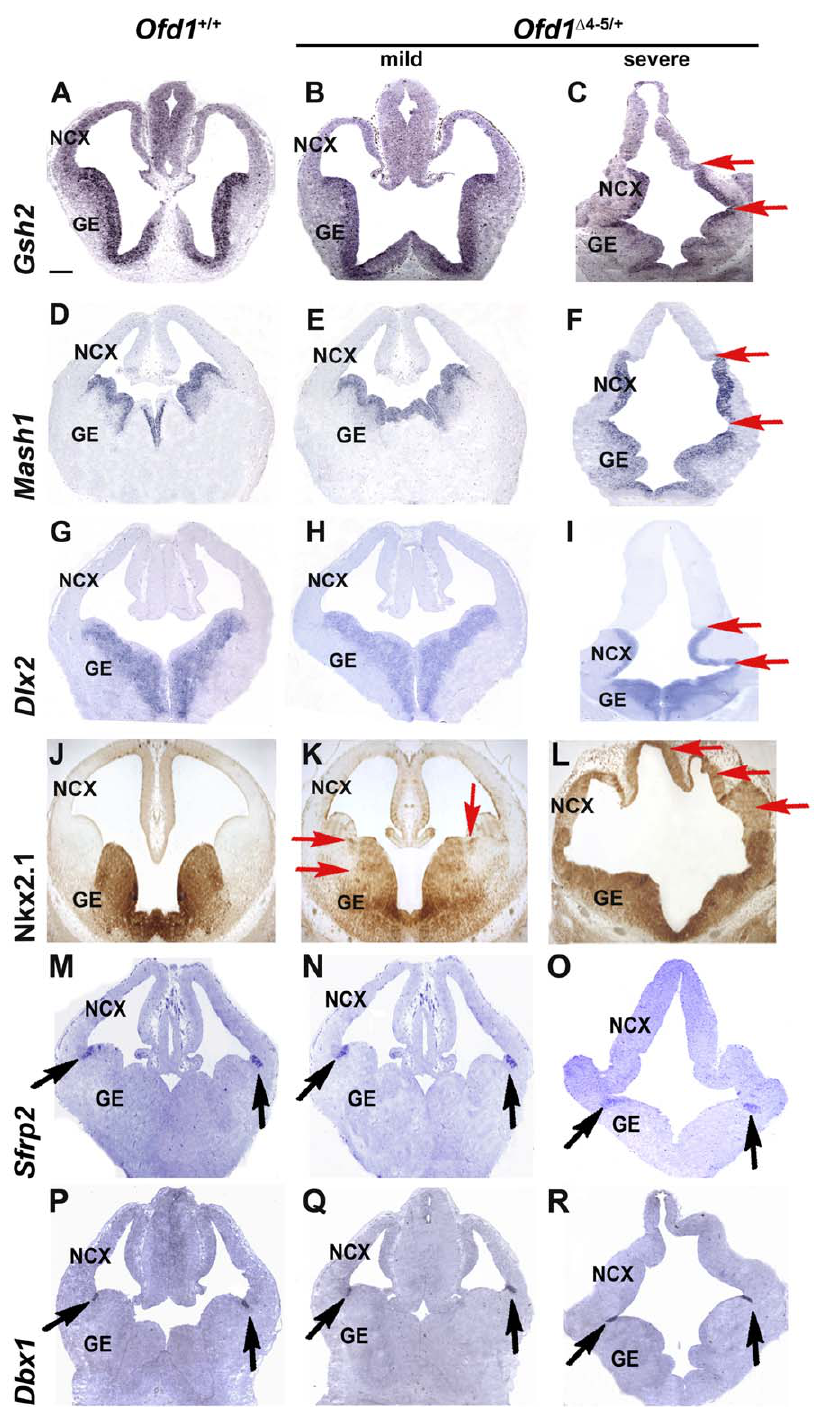
Figure 3. Markers of the ventral telencephalon are ectopically expressed in the dorsal telencephalon of Ofd1 mutant embryos. ISH analysis showed that Gsh2 , Mash1 and Dlx2 genes are all expanded dorsally into the neocortex of Ofd1 D 4–5/ + heterozygous females with a severe phenotype (red arrows in C, F, I) compared to Ofd1 + / + wild-type embryos (A, D, G). Immunohistochemical analysis for the ventral marker Nkx2.1 reveals an ectopic expression in the dorsal part of the brain with a severe phenotype (L) when compared to Ofd1 + / + wild-type embryos (J). We do not observe any difference in the expression pattern of ventral markers on brain sections of Ofd1 mutants displaying a mild phenotype (B, E, H) with the exception of Nkx2.1, which is slightly mis-expressed in the LGE (red arrows in K) and it is ectopically induced at lower levels in the dorsal telencephalon (red arrows in L). The analysis of the expression pattern of Sfrp2 and Dbx1 genes at the boundary between pallial and subpallial zones (PSBP) demonstrated that these transcripts show a normal expression domain in Ofd1 D 4–5/ + heterozygous females (black arrows in N, O, Q, R) when compared to wild-type animals (black arrows in M, P). Dorsal is upwards, ventral is downwards. Scale bars: 150 m m. NCX: neocortex. GE: ganglionic eminences.